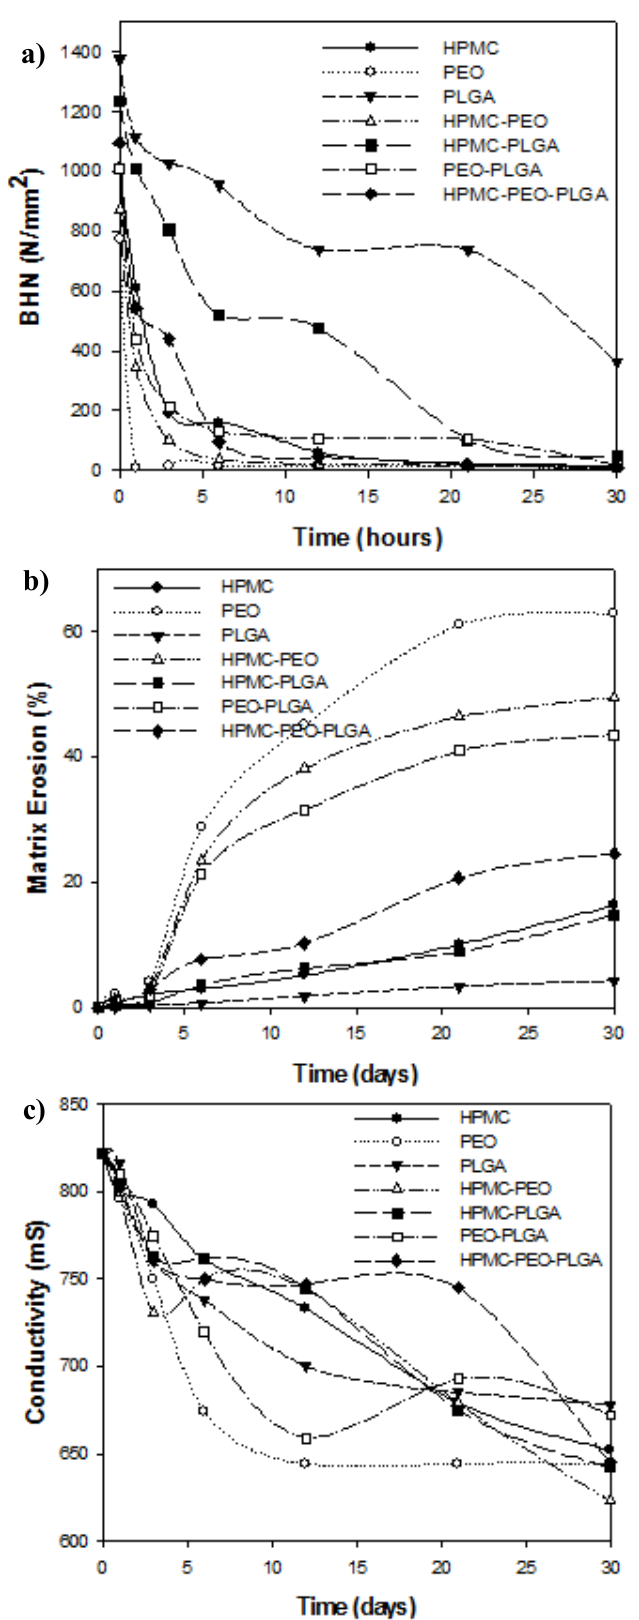
Figure 1. Physical properties of compressed polymeric discs following exposure to simulated CSF over a period of 30 days: ( a ) Changes in the Brinell Hardness Number (N/mm 2 ; N = 3; SD < 23.67 N/mm 2 ); ( b ) Matrix erosion (%; N = 3; SD < 0.05%); and ( c ) Changes in conductivity ( µ Siemens; N = 3; SD < 16.34 µS).